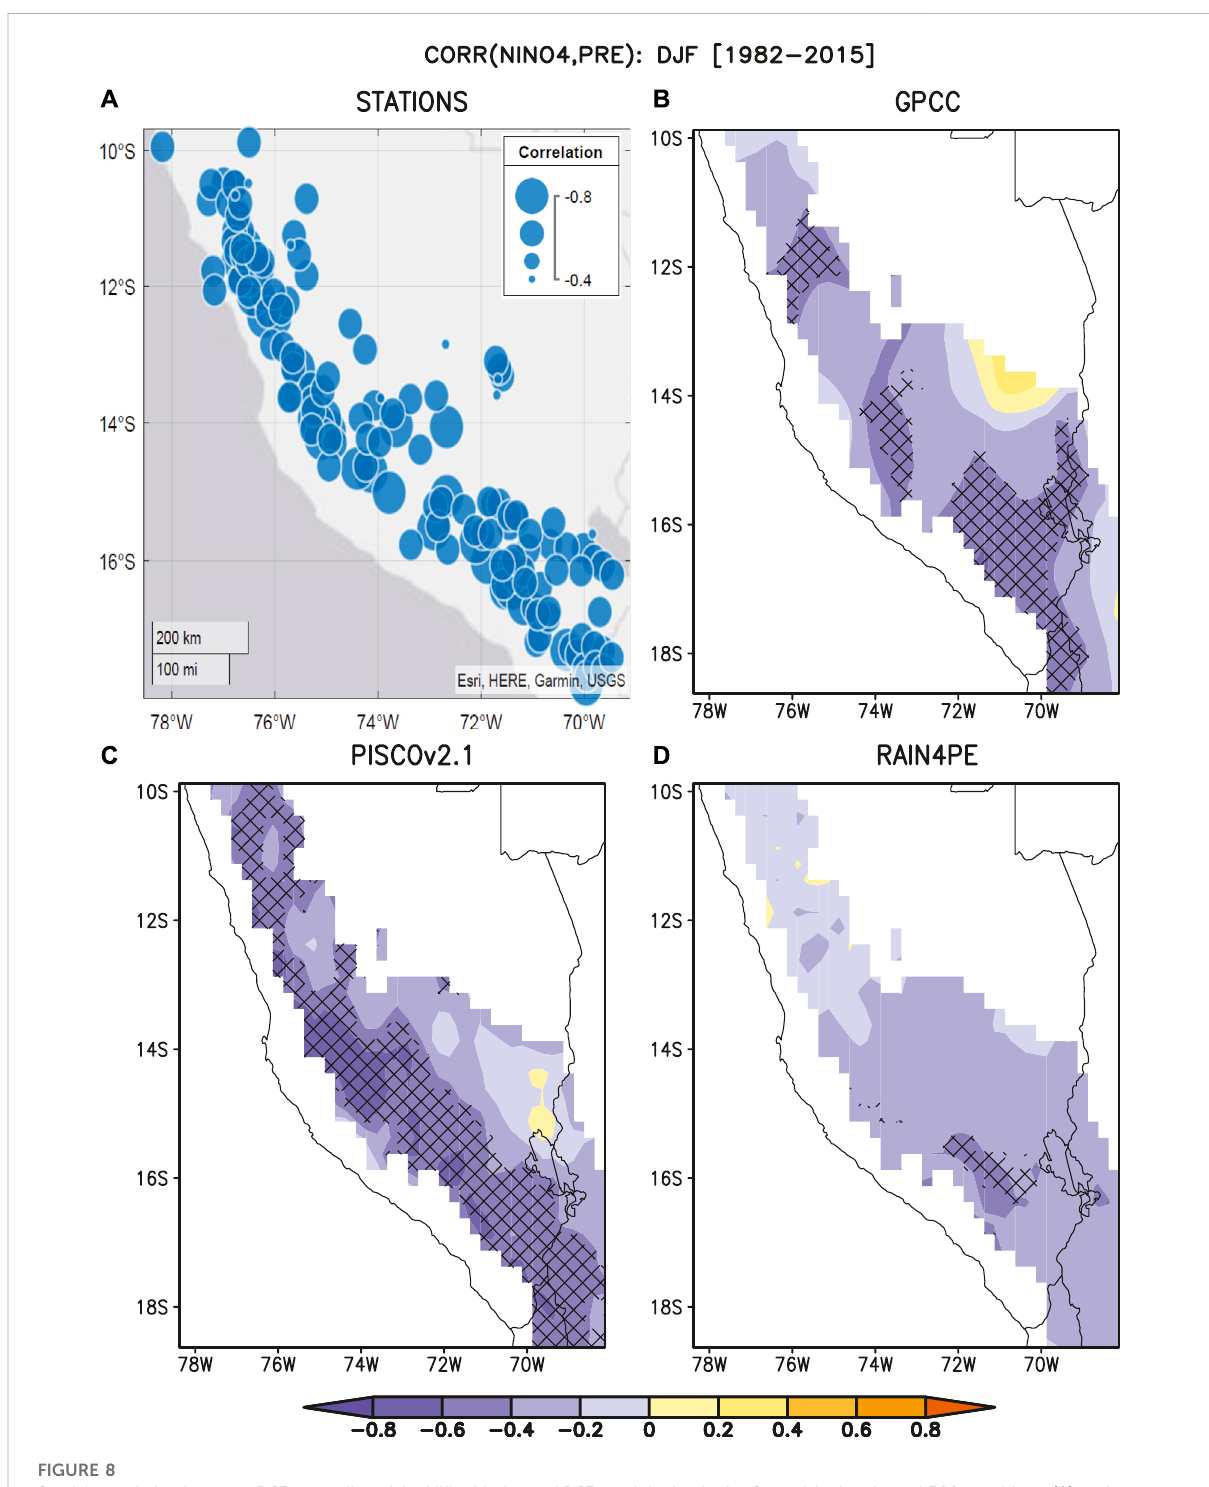
FIGURE 8 Spatial correlation between DJF anomalies of the Niño 4 index and DJF precipitation in the Central Andes above 1,500 m asl from (A) stations, (B) GPCC, (C) PISCOv2.1 and (D) RAIN4PE datasets. The analysis is based on the 1982 – 2015 period. Blue circles represent statistically signi fi cant correlation at the 95% con fi dence level in rain-gauge stations. Hatching indicates regions with a statistically signi fi cant correlations at the 95% con fi dence